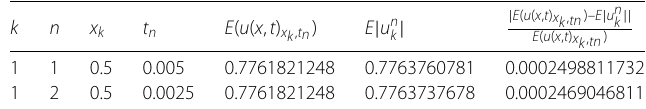
Table 4 β ∼ Beta distribution(1.0,2.0), α = 1